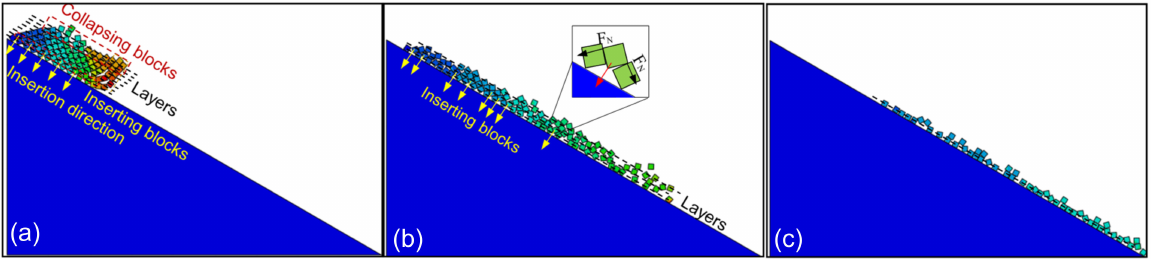
Figure 11. The process of stabilization of sliding mass structure during mass movement. ( a ) initial failure state; ( b ) dynamic sliding process ( c ) final stable